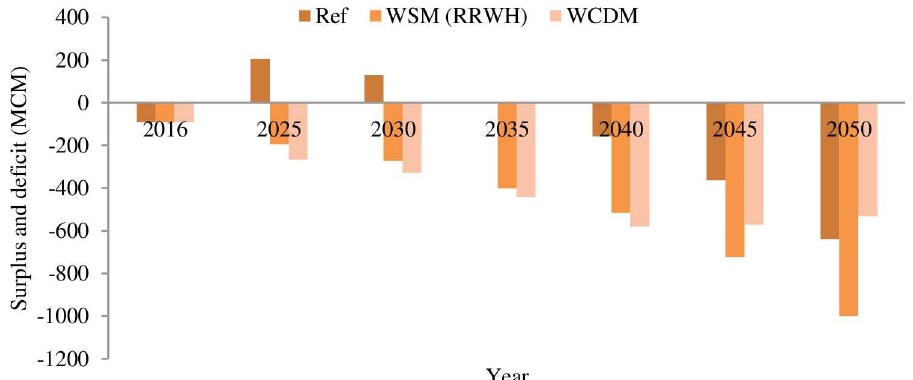
Fig 13. Water supply-demand gap. The water supply increases in 2030 and 250 by 823 and 1426 MCM respectively through the water management intervention. The new water supply and balance index can be seen in Table 12.